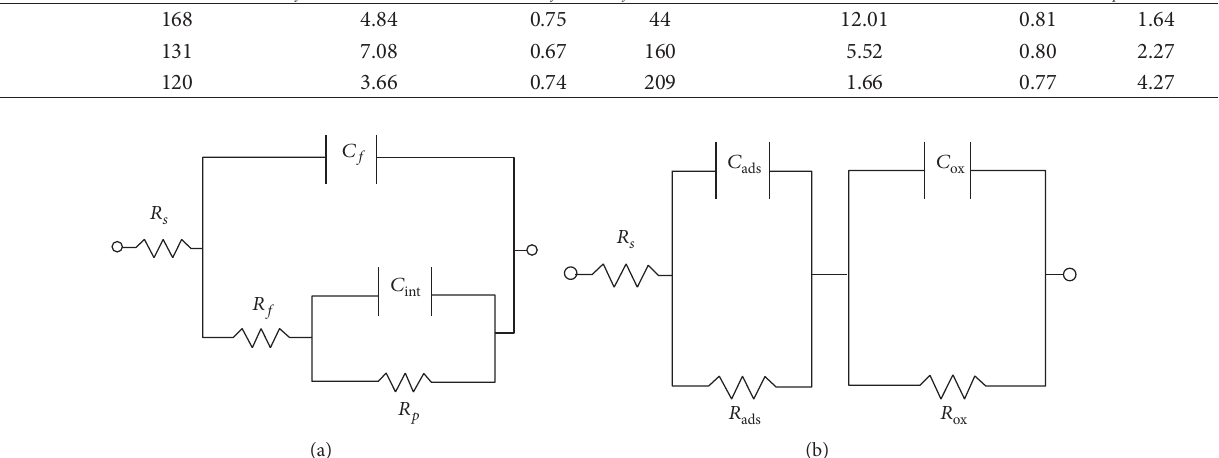
Figure 3: Equivalent circuit models used to fit the experimental results (a) in the blank and solutions with glutarate concentrations < 32mM and (b) for glutarate concentrations ≥ 32 mM.